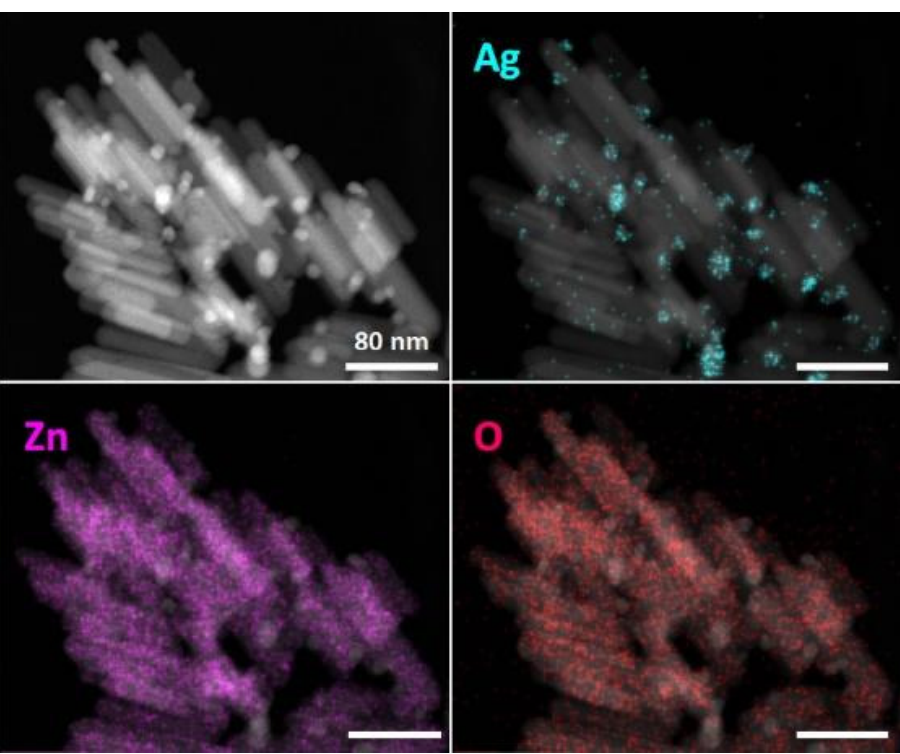
Figure 1. STEM–EDX analysis of ZnO/Ag nanoparticles. HAADF-STEM images combined with EDX mapping results for silver (Ag, L α ) in blue, zinc (Zn, K α ) in violet and oxygen (O, K α ) in red show the homogeneous distribution of elemental Zn and O and the presence of Ag in nanoparticle formulations. Scale bars correspond to 80